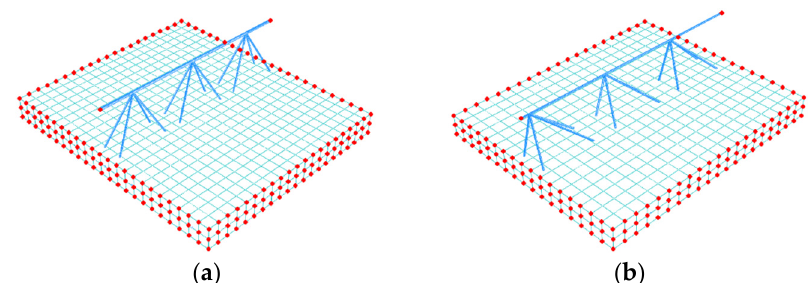
Figure 10. RVE—external (in red colour) and internal nodes ( a ) Type-D; ( b ) Type-EQ.